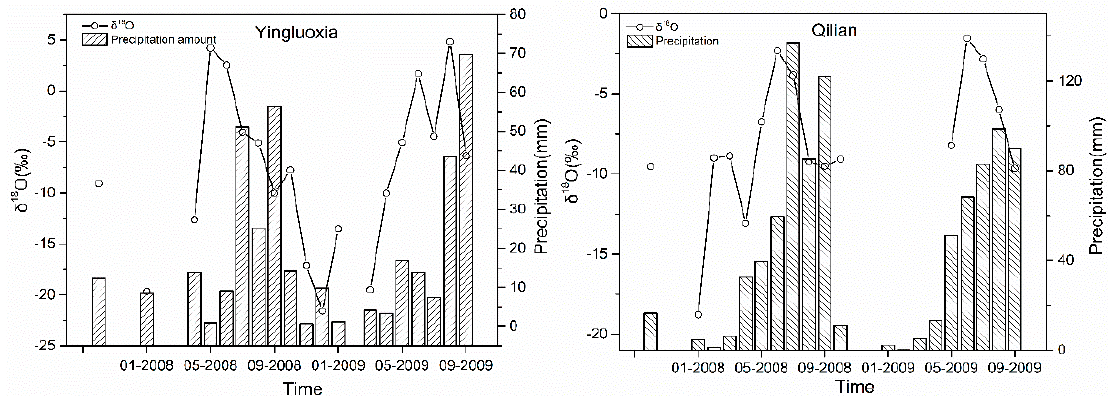
Figure 2. Time series of precipitation and δ 18 O ratio of rainfall (2007.10–2009.9).